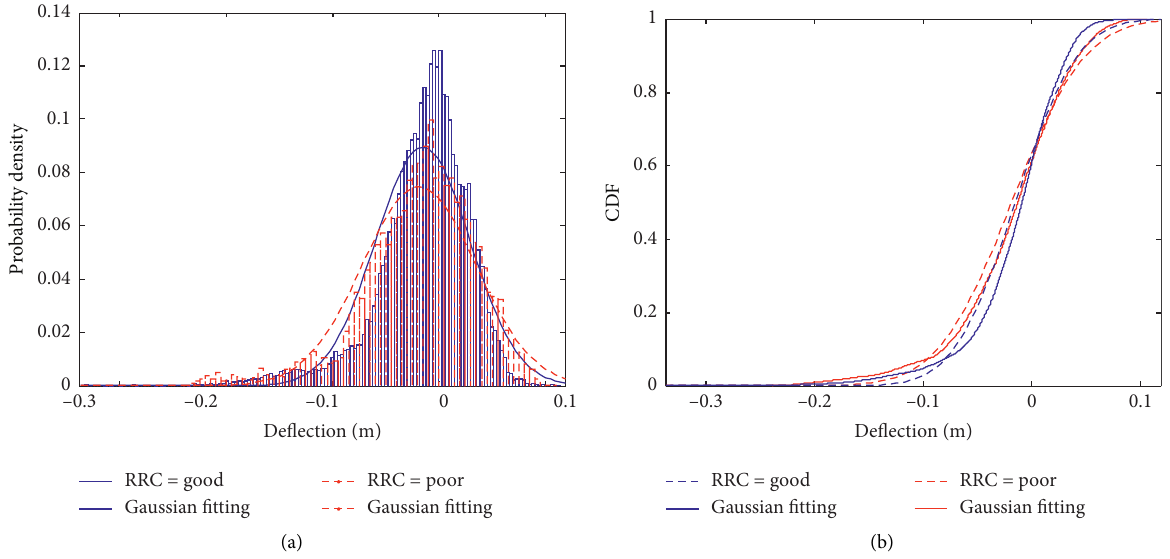
Figure 12: Probability distribution of the critical deflection: (a) PDF; (b) CDF.